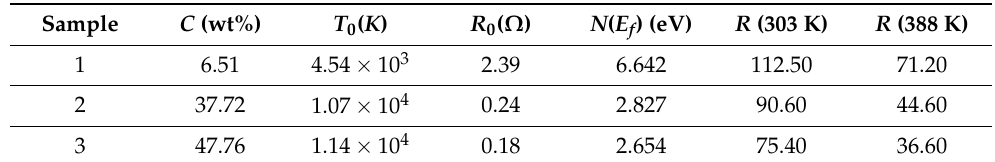
Table 3. VRH fitting parameters for the nanocomposite samples at fixed amount of PEDOT:PSS and different concentrations of MWCNTs.